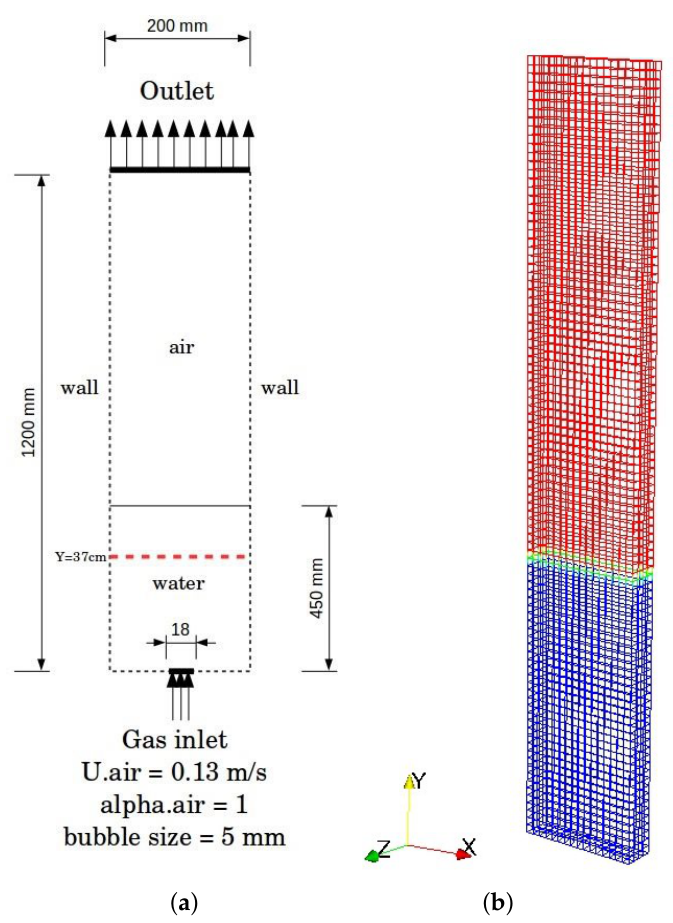
Figure 1. ( a ) Dimension and boundary conditions in the bubble column [1] and ( b ) mesh. Table 9. Models used in the simulation of the bubble column of Pfleger et al. [62]. TFM, Two-Fluid Model.